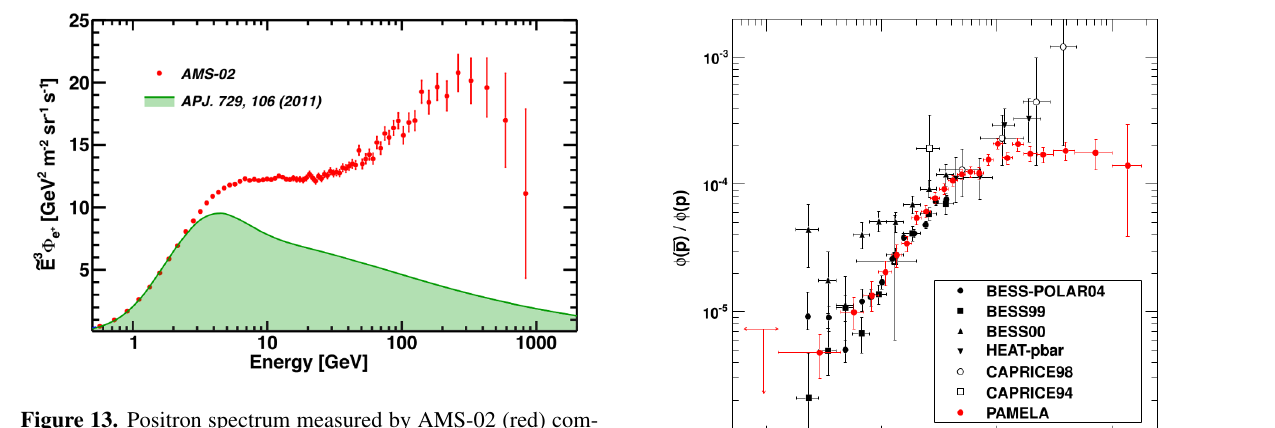
Figure 13. Positron spectrum measured by AMS-02 (red) com- pared with the prediction of the Galprop model (green) for the purely secondary positrons [6].